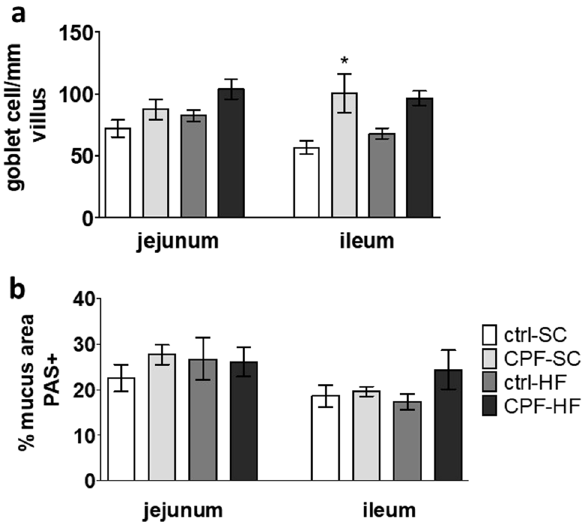
Figure 8. Histological measurements of digestive segments in male offspring at young adult age from CPF and/or HFD exposed mothers. ( a ) Goblet cells count/mm villus and ( b ) % of mucus area PAS + in jejunal and ileal segments. Values are expressed as the mean ± SEM (n = 5–20) *Significantly different (p < 0.05) from ctrl-SC using the analysis of variance (ANOVA) and a subsequent post hoc Bonferroni test. ctrl control, CPF Chlorpyrifos, HF high fat, SC standard chow, PAS periodic acid